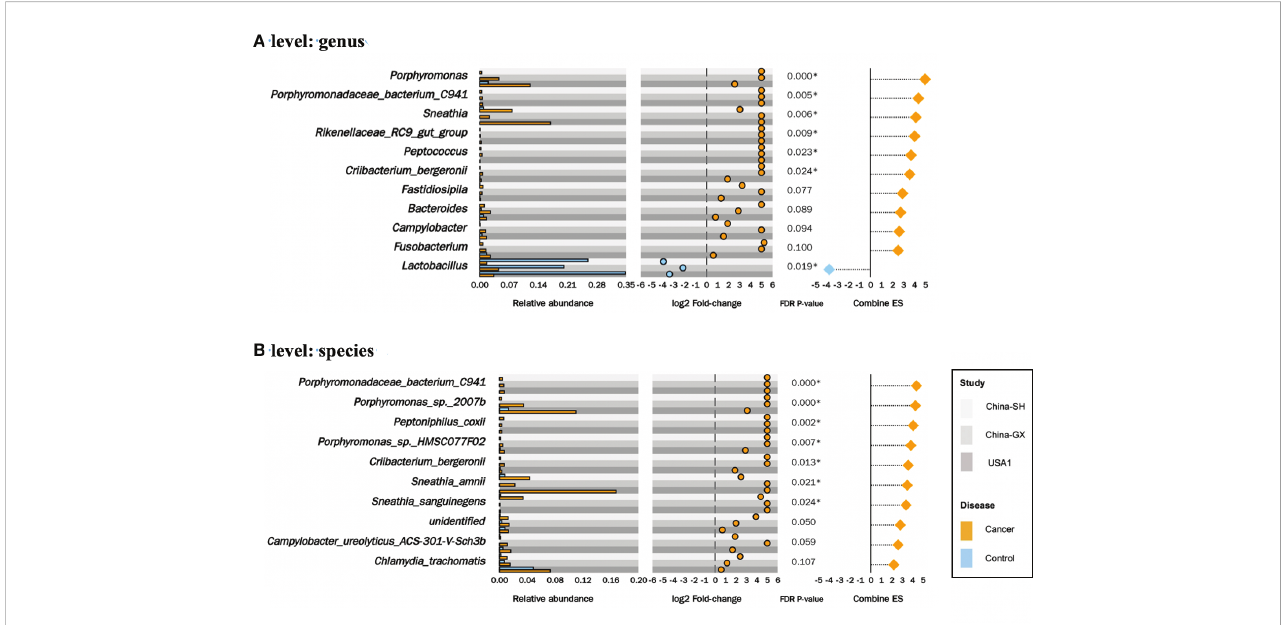
FIGURE 5 Signi fi cantly changed taxa in cervical cancer. The relative abundances in cervical cancer versus controls for the 6 genera (A) and 7 species (B) signi fi cantly enriched and 1 genus decreased (A) in the meta-analysis, along with their log2 fold-changes in the 3 datasets, combined effect